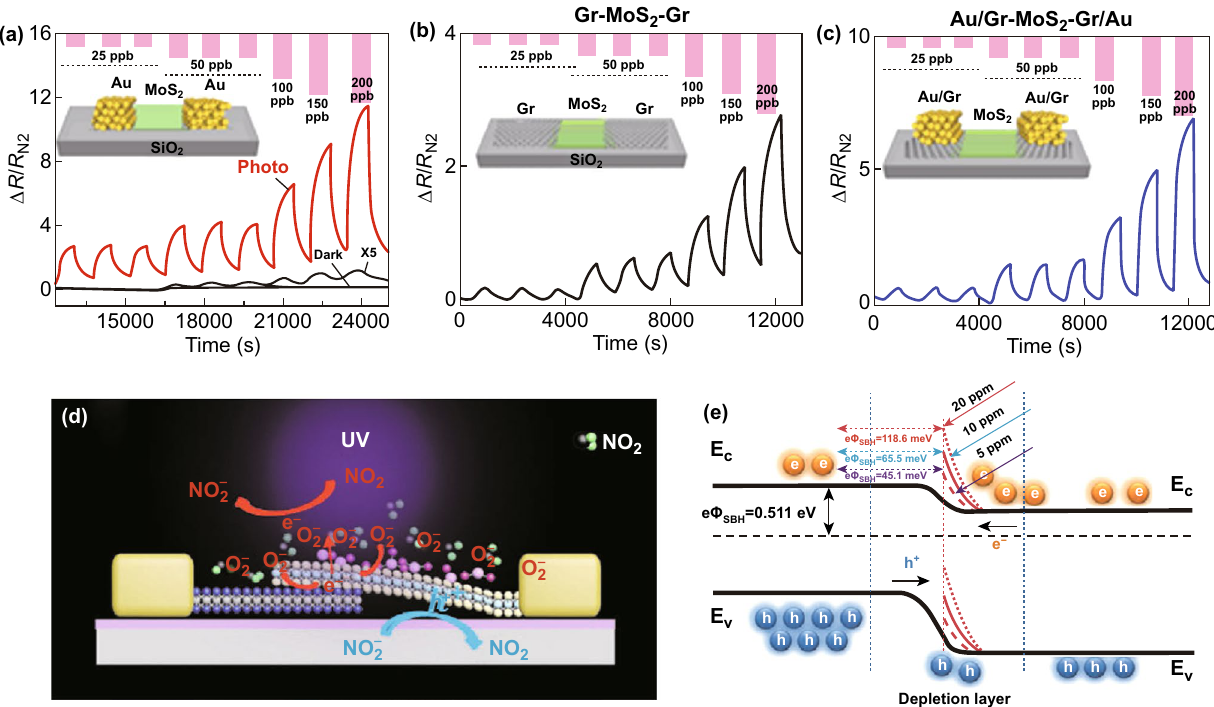
Fig. 14 Gas response to different concentrations of NO 2 gas at room temperature under red light illumination of a Au/MoS 2 /Au, b Gr/MoS 2 /Gr, and c Au/Gr-MoS 2 -Gr/Au device. Reproduced with permission [120]. Copyright 2019, American Chemical Society. d Schematic representation of an n–p-type van der Waals homojunction of MoS 2 under UV illumination. e Gas sensing mechanism of the n–p-type van der Waals homo- junction of MoS 2 via energy band diagram. Reproduced with permission [126]. Copyright 2020, WILEY ‐ VCH Verlag GmbH & Co. KGaA,